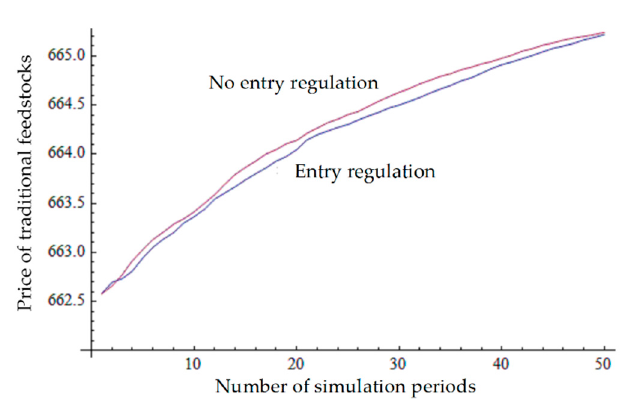
Figure 8. Impact of entry regulation on the price of feedstock.